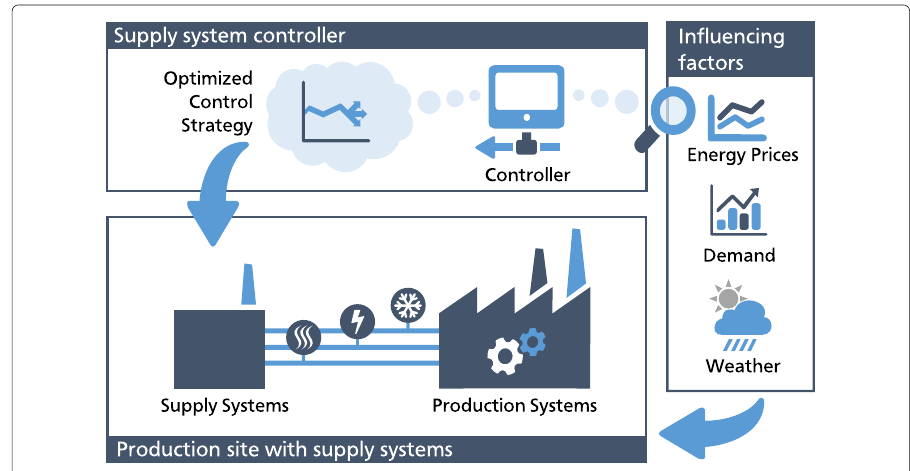
Fig. 1 Problem description. Influencing factors such as energy prices, weather conditions and energy demand of production facilities influence the operating behavior of industrial energy supply systems. Advanced control strategies for supply systems have to take these factors into account to derive optimized control